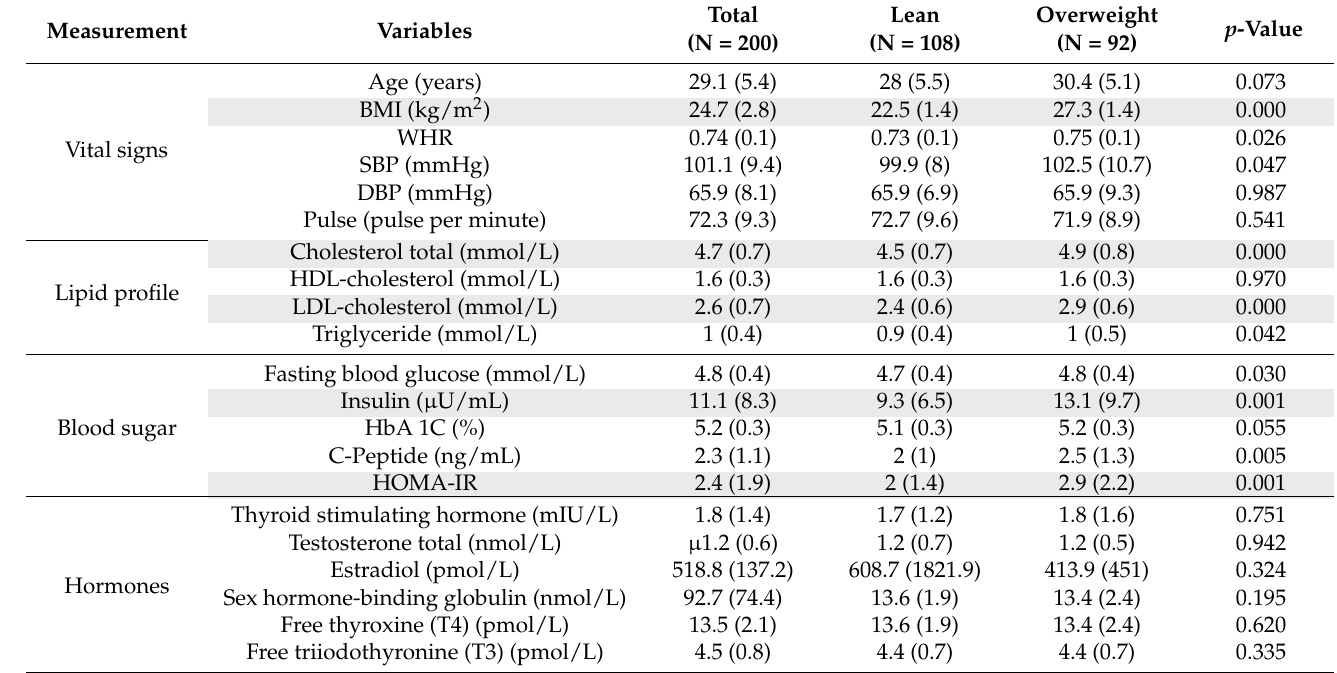
Table 1. General characteristics of participants. Abbreviations: BMI—body mass index, WHR—waist-to-hip ratio, SBP—systolic blood pressure, DBP—diastolic blood pressure, LDL—low-density lipoprotein, HDL—high-density lipoprotein, HbA1C— hemoglobin A1c, HOMA-IR—homeostatic model assessment of insulin resistance, ALP—alkaline phosphatase, ALT—alanine transaminase, AST—aspartate aminotransferase). Data are presented as mean (SD). Differences between lean and overweight were tested by independent sample t-test (normally distributed variables) or Mann–Whitney U (variables with skewed distribution) test. A p -value level of 0.001 was used to infer significance. Accordingly, significant differences are highlighted.